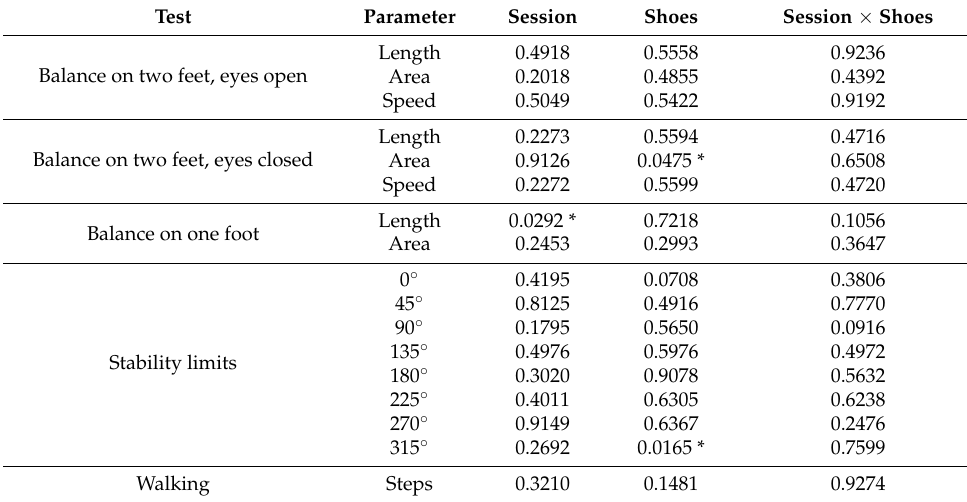
Table 2. Results of repeated measure analysis of variance ( p values).